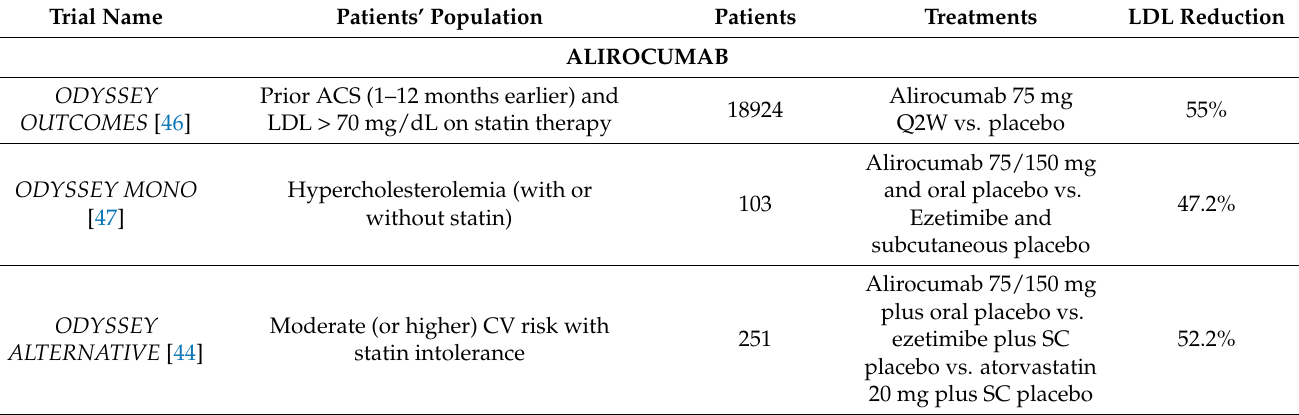
Table 1. List of trials on PCSK9i with characteristics of patients’ population, number of patients enrolled and percentage of LDL-C reduction achieved. ACS: acute coronary syndrome; CV: cardio- vascular; HeFH: heterozygous familiar hypercholesterolemia; HoFH: homozygous familial hyperc- holesterolemia; IRA: infarct related artery; LLT: lipid lowering therapy; NK: not known; Q2W: once every 2 weeks; SC: